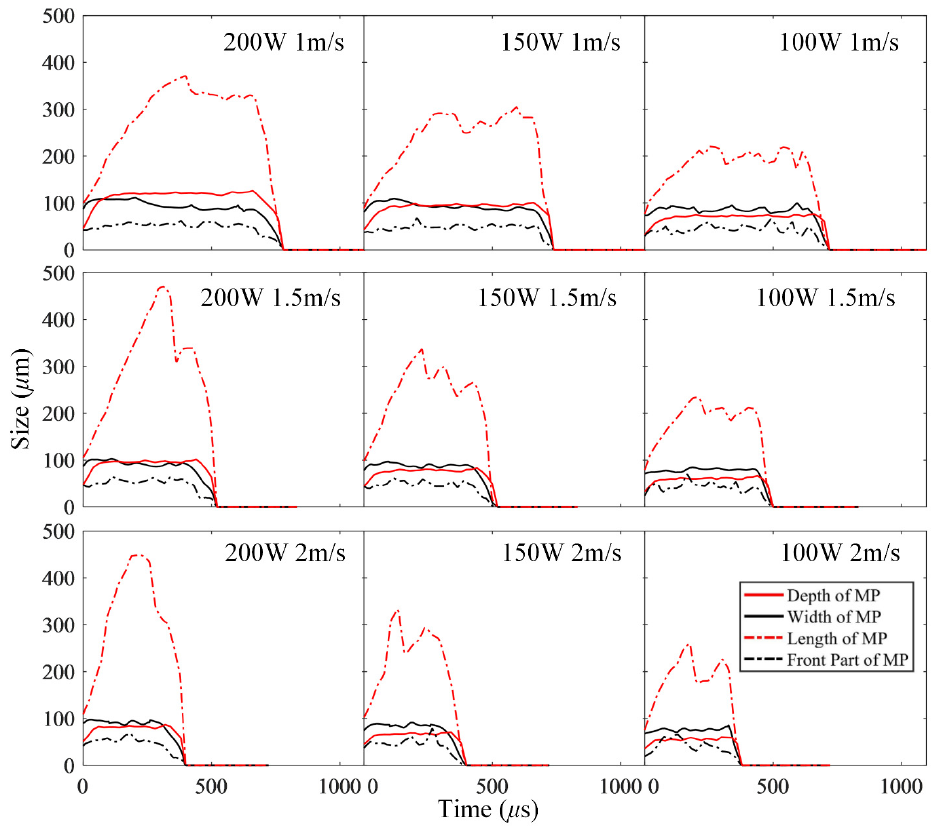
Figure 9. The dimensions of the molten pool (MP) during laser scanning under different laser powers and scanning speeds. To further examine the dependence of the molten pool dimensions on the laser power and scanning speed, we plotted the depth and width of the molten pool versus the linear energy density of the laser power in Figure 10, where the linear energy density is the laser power divided by the scanning speed. The values of the depth and width were evaluated by averaging the molten pools when the melting is essentially stable, and the error bars indicate the size fluctuations. It can be seen that the depth increases almost linearly with the increase of energy density while the width increases rapidly and then very slowly. Their increments indicate that the depth increases more than the width does. The error bars also indicate that the width of the molten pool shows much stronger fluctuation un- der a higher linear energy density of the laser power.